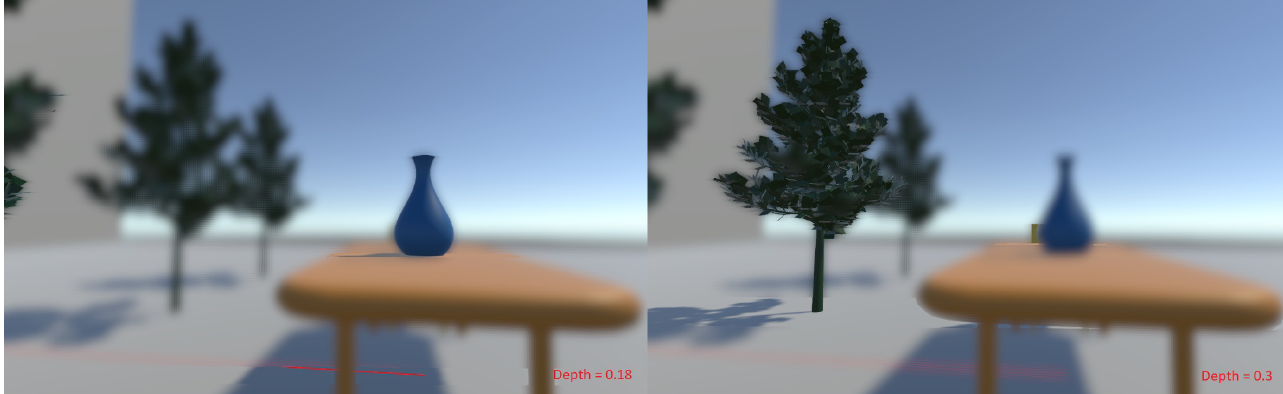
Figure 4. Depth-of-field effects for different planes of fixation. Points of fixation (depth values are reported in red on the images) are on the vase and the front tree in the left and right images, respectively.